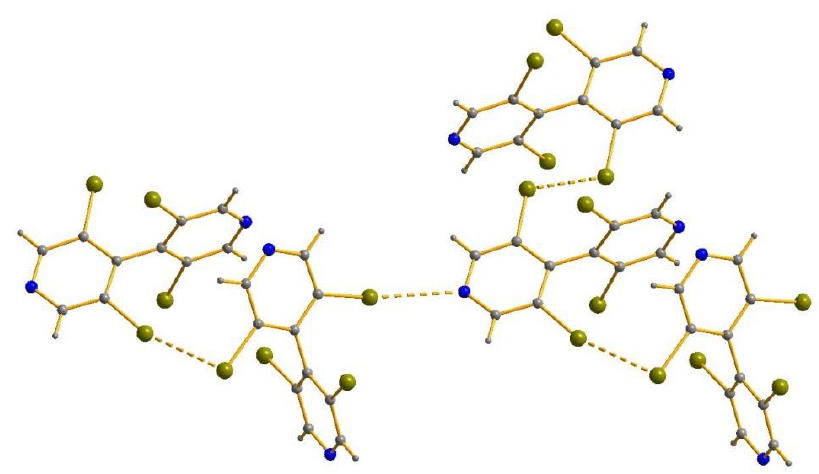
Figure 4. The system of Br ⋯ Br interactions (dashed) in 1.